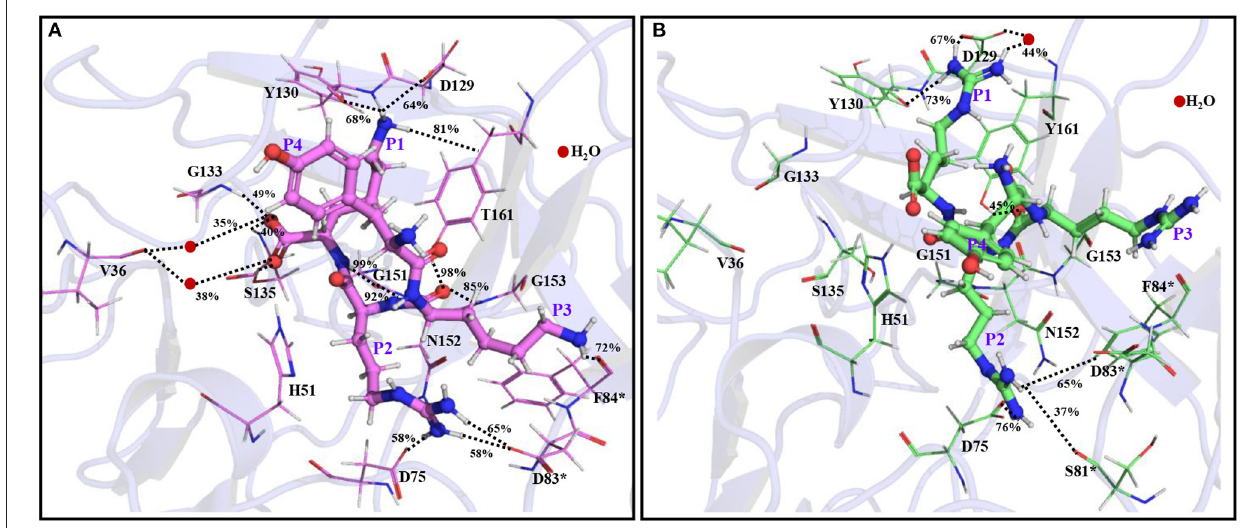
FIGURE 2 | The average simulated structures of (A) YKRK-protease and (B) YRRR-protease complexes. The residues of NS2B are marked by *. The hydrogen bonding and ionic interactions are shown by dotted lines. The percentage occupations of different interactions are also mentioned. The P1-P4 residues of the inhibitors are